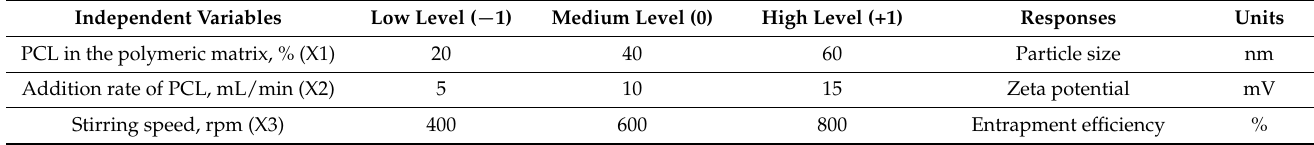
Table 1. Independent and dependent variables and their levels utilized in Box-Behnken